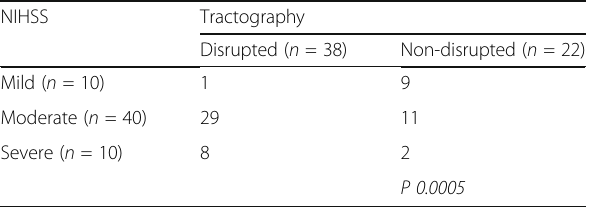
Table 4 Correlation between the tractography findings